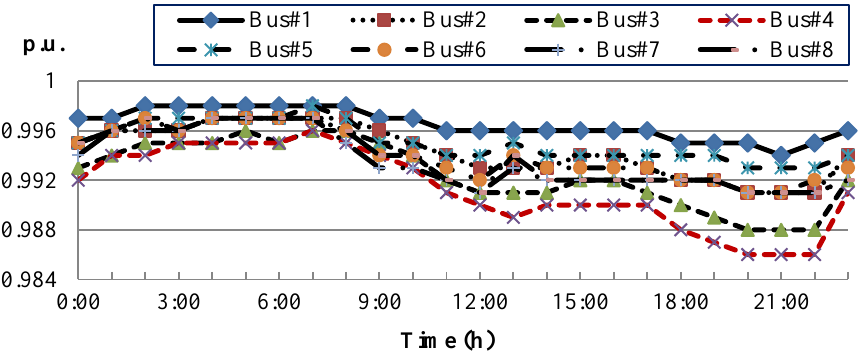
Figure 9. Numerical results of bus voltage under grid-tied operation.